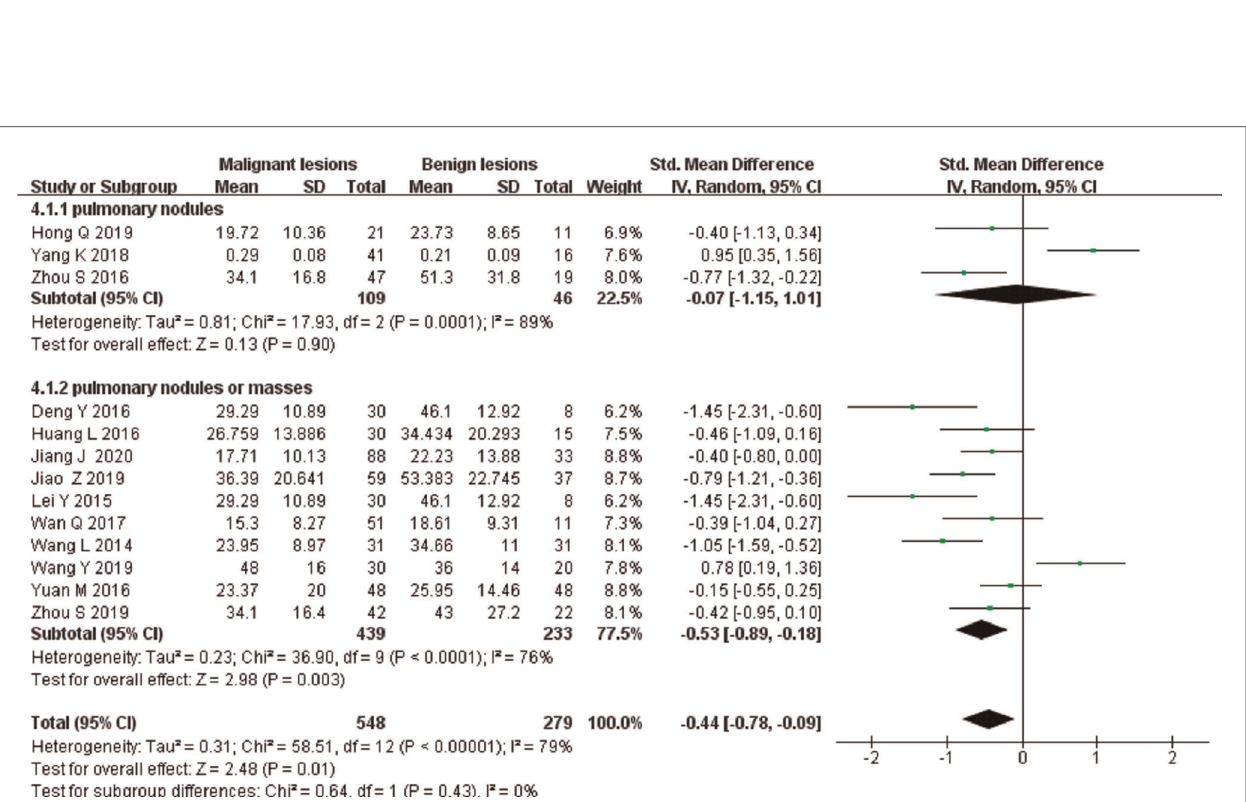
FIGURE 6 | Forest plot of the mean value of the pseudo diffusivity ( D * value) between malignant and benign pulmonary nodules and masses.